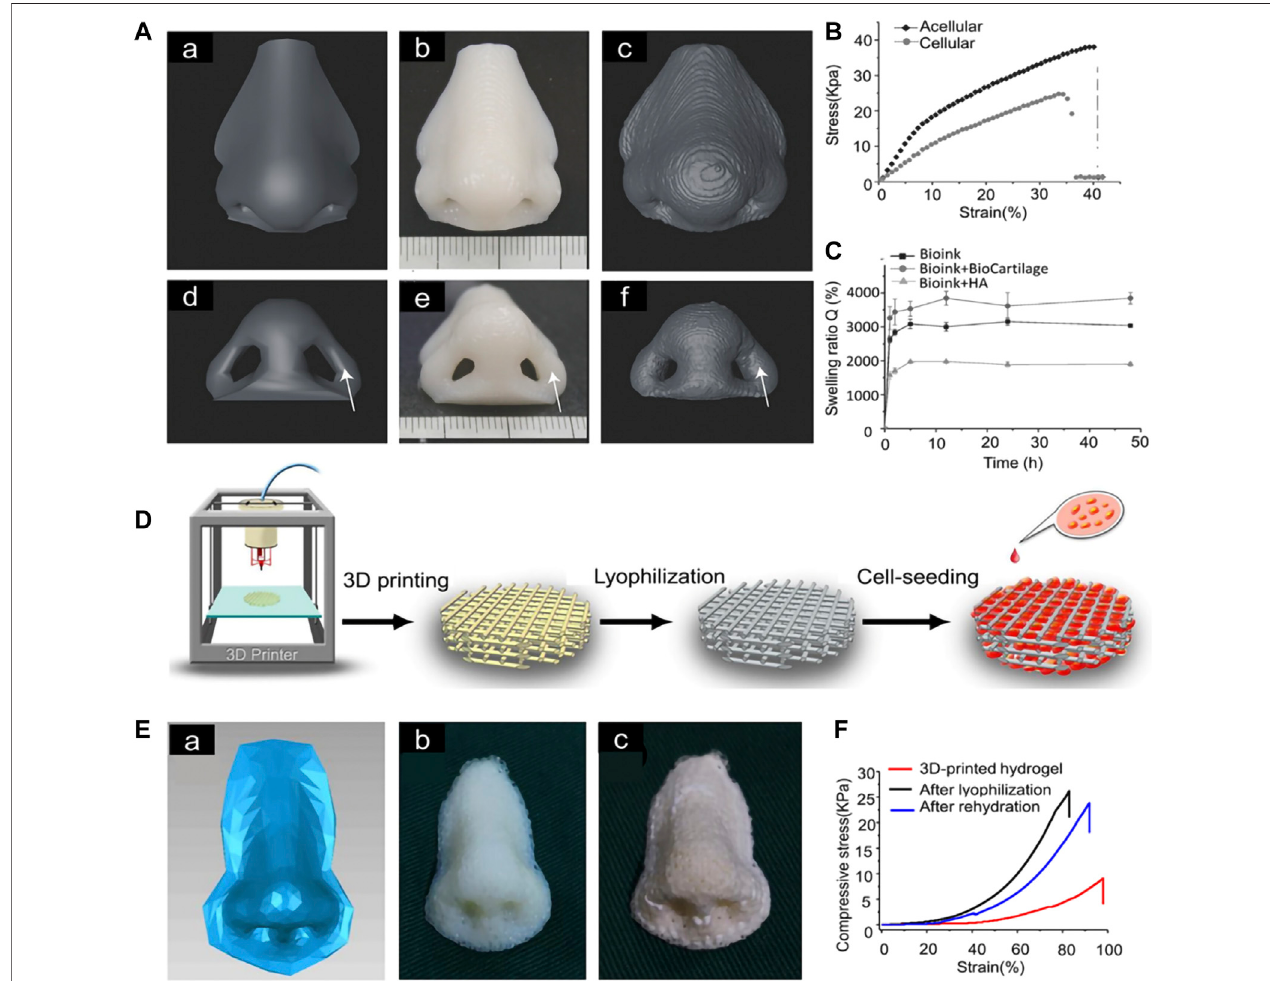
FIGURE 3 | 3D-printed nasal cartilage scaffold. (A) The 3D model for printing and comparison of its shape and volume after 2 weeks of swelling (B) The Young ’ s modulusoftheacellularstructure(E (cid:2) 230 ± 7.0 kPa)wassigni fi cantlyhigherthanthatofthecellularstructure(E (cid:2) 116 ± 6.8 kPa). (C) Theequilibriumswellingrateofbio- ink+HAwassigni fi cantlylowerthanthatofbio-ink+biocartilageorbio-inkalone(Kestietal.,2015). (D) Nasalcartilagescaffoldwaspreparedbyphotocured3Dprinting and lyophilization. (E) The scaffold printed according to the 3D model was lyophilized. (F) compression strength of the scaffold (Xia et al., 2018).